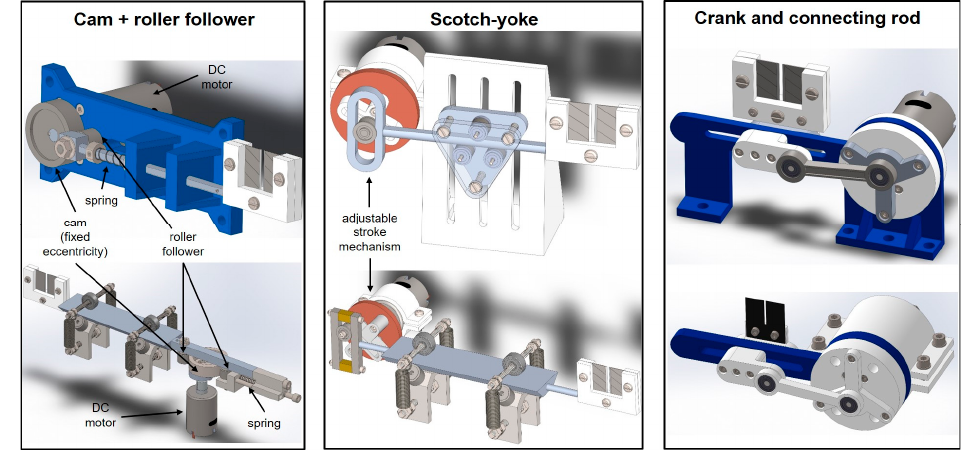
Figure 7. Design of reciprocating mechanisms.